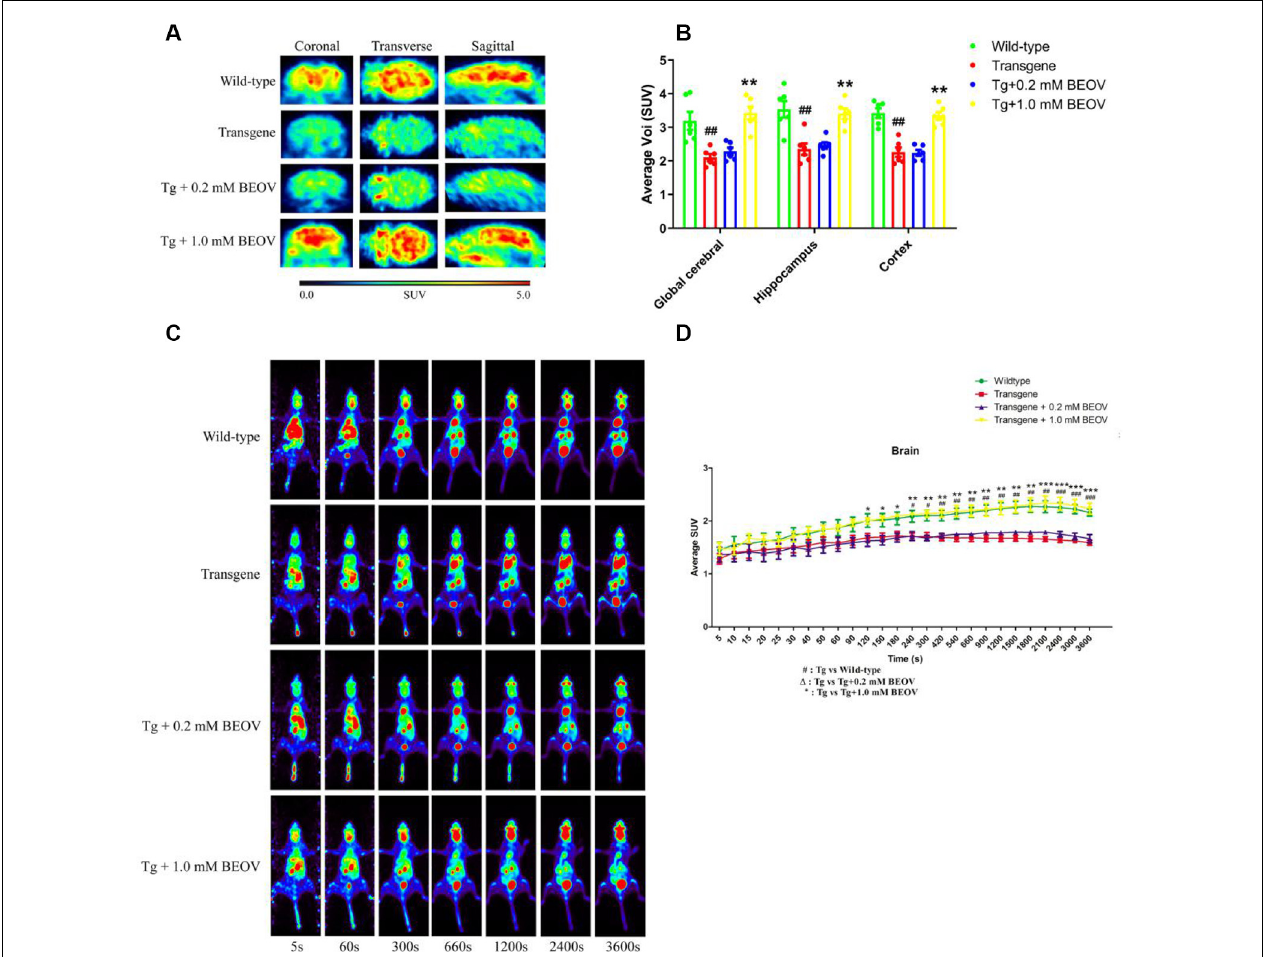
FIGURE 2 | BEOV promoted glucose uptake in the brain of APPSwe/PS1dE9 mice. (A) Static imaging of cerebral glucose uptake by the 18 F-FDG PET in the WT, APPSwe/PS1dE9, and BEOV-treated APPSwe/PS1dE9 mice at the age of 9 months. (B) Quantitative analysis of 18 F-FDG uptake in global cerebral, hippocampus and cortex of the mice. (C,D) Dynamic imaging of cerebral glucose uptake and quantitative analysis of 18 F-FDG uptake levels in mouse brain from 5 to 3,600 s. # WT group vs. AD group; *AD + BEOV group vs. AD group. n = 6, three females and three males; # P < 0.05, ## P < 0.01, ### P < 0.001, * P < 0.05, ** P < 0.01, and *** P < 0.001,